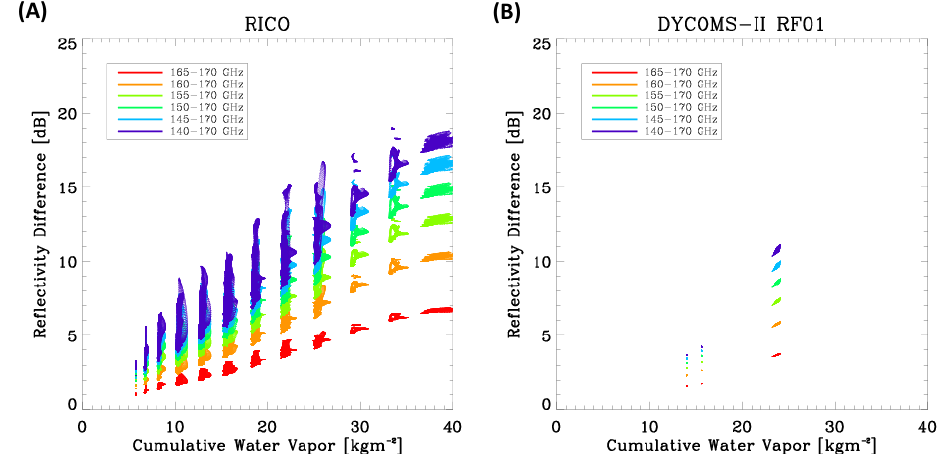
Figure 7. A scatter plot of the water vapor path ( u vapor ) between the radar and the target range gate and the reflectivity difference. RICO is shown in (a) and DYCOMS-II RF01 is shown in (b) . These points have been convolved with the antenna function and range resolution. The slope of the relationship is interpreted as a signal, and the scatter about that slope is the noise due to natural variability. Notice that the scatter is much larger in the RICO simulation than in the DYCOMS-II RF01 simulation. Signal increases with frequency separation; however, the noise does as well. The clusters of points with the largest vapor paths correspond to the surface